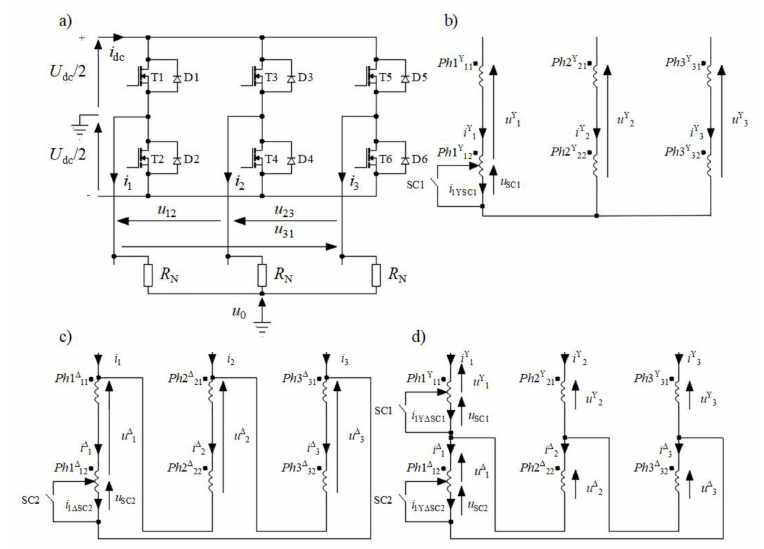
Figure 2. The schematic diagram ( a ) of the power supply of the BLDC motor and of the winding configurations: ( b ) star (Y), ( c ) delta ( ∆ ) and ( d ) mixed star-delta configuration (Y ∆ ).